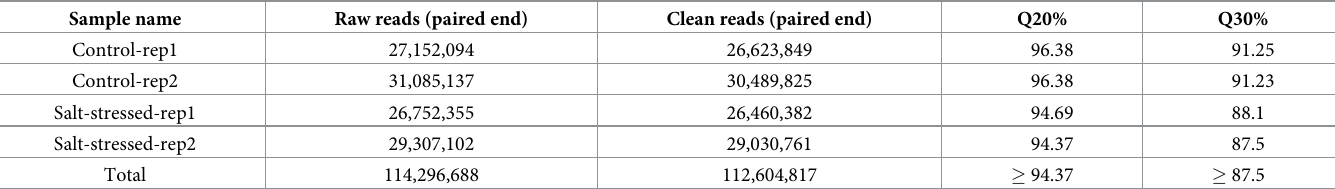
Table 1. Summary of sequencing results.